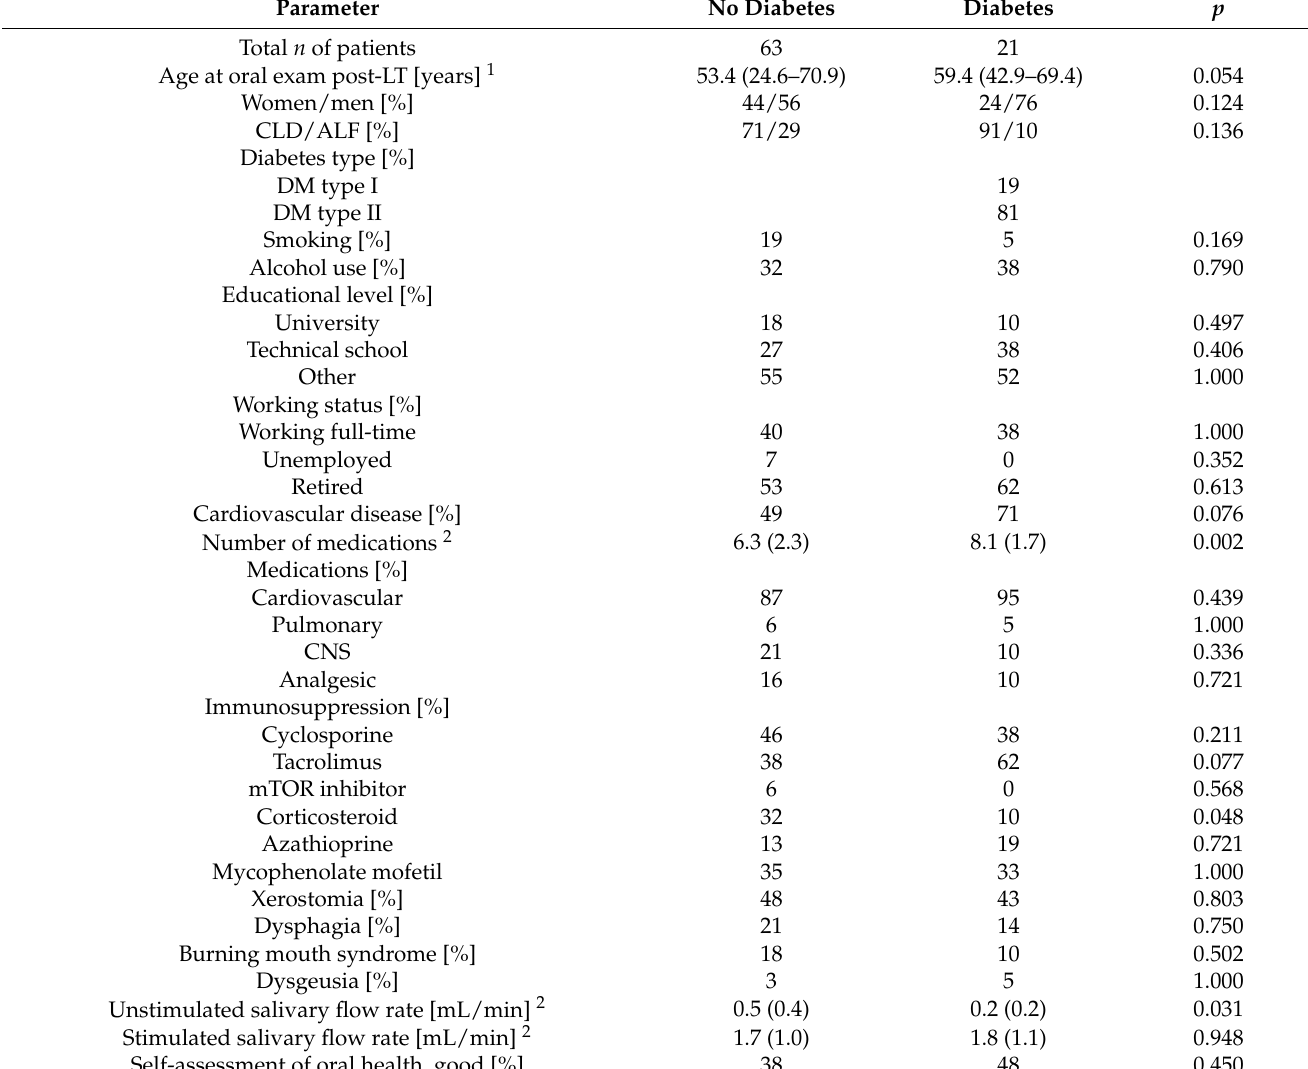
Table 1. Background, medications, and oral symptoms of liver transplant recipients with and without diabetes, after liver transplantation.